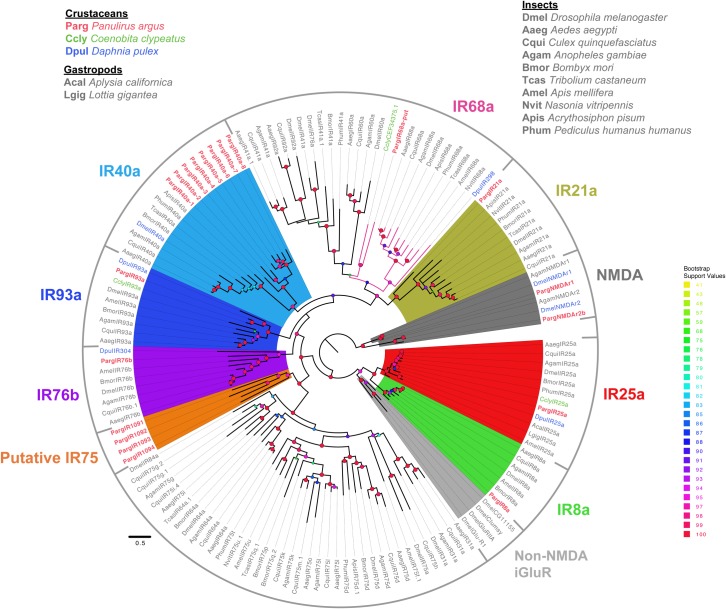
Maximum likelihood phylogenetic tree of homologous sequences of conserved IRs.Only conserved IR groups with Parg homologues are colored. Pink branches represent homologous sequences of IR68a with the Ccly sequence, the putative PargIR68a-put, and DpulIR298 as crustacean representatives. Sequences were aligned with MAFFT and visualized on Jalview for editing. The tree was built on IQ-Tree under LG+F+G4 model of substitution with 1000 UFBoot replications and visualized on FigTree v1.4.2. Bootstrap values in some internal nodes are low due to incomplete sequences. The tree was unrooted but drawn with the NMDA clade as the root. The scale bar represents the expected number of substitutions per site.